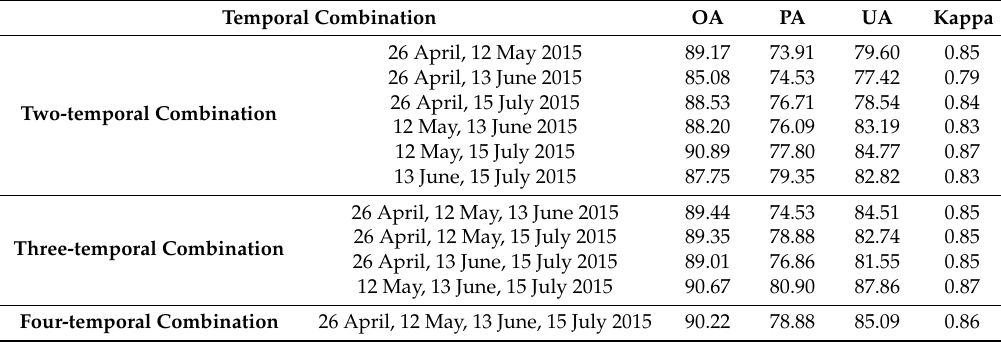
Table 11. The mapping accuracy generated from RF using the combined multi-temporal features in Guyuan.